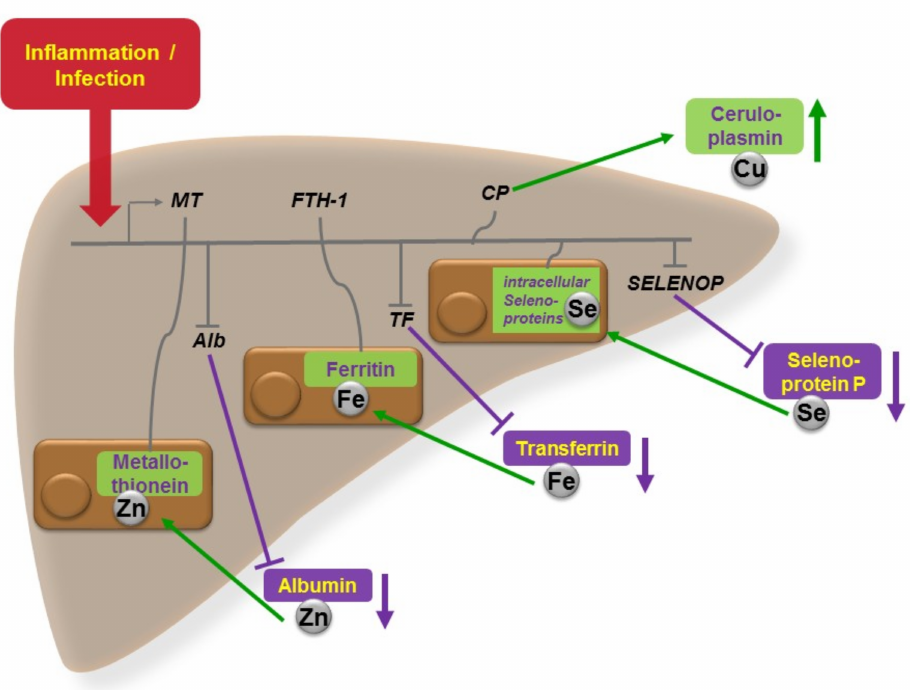
Figure 1. Central role of liver in acute phase regulation of circulating trace elements. In response to infection or inflammation, and the associated increase in pro-inflammatory cytokines, hepatocytes modify trace element metabolism, in order to deprive invading pathogens from supply with essential growth factors, and at the same time, improving the host’s anti-inflammatory response. The figure depicts schematically the e ff ects on the distribution of copper (Cu), iron (Fe), selenium (Se), and zinc (Zn) between blood and liver. Serum Cu levels increase in response to inflammation mainly via up-regulated ceruloplasmin (CP) biosynthesis and secretion into blood. The hepatic hormone hepcidin diminishes Fe supply to the circulation and at the same time, transferrin concentrations decline, while intrahepatic ferritin (FTH-1) increases, collectively reducing circulating Fe levels (anaemia of inflammation). Hepatic selenoprotein biosynthesis becomes redirected in favor of certain intracellular selenoproteins and at the expense of the circulating Se-transport protein selenoprotein P (SELENOP). The re-distribution of Zn is more complex, involving all major organs, including immune cells and the gastrointestinal system, and a large number of Zn-dependent proteins [1]. A significant flow of Zn levels takes place from circulating albumin into hepatocytes and toward intracellular metallothioneins